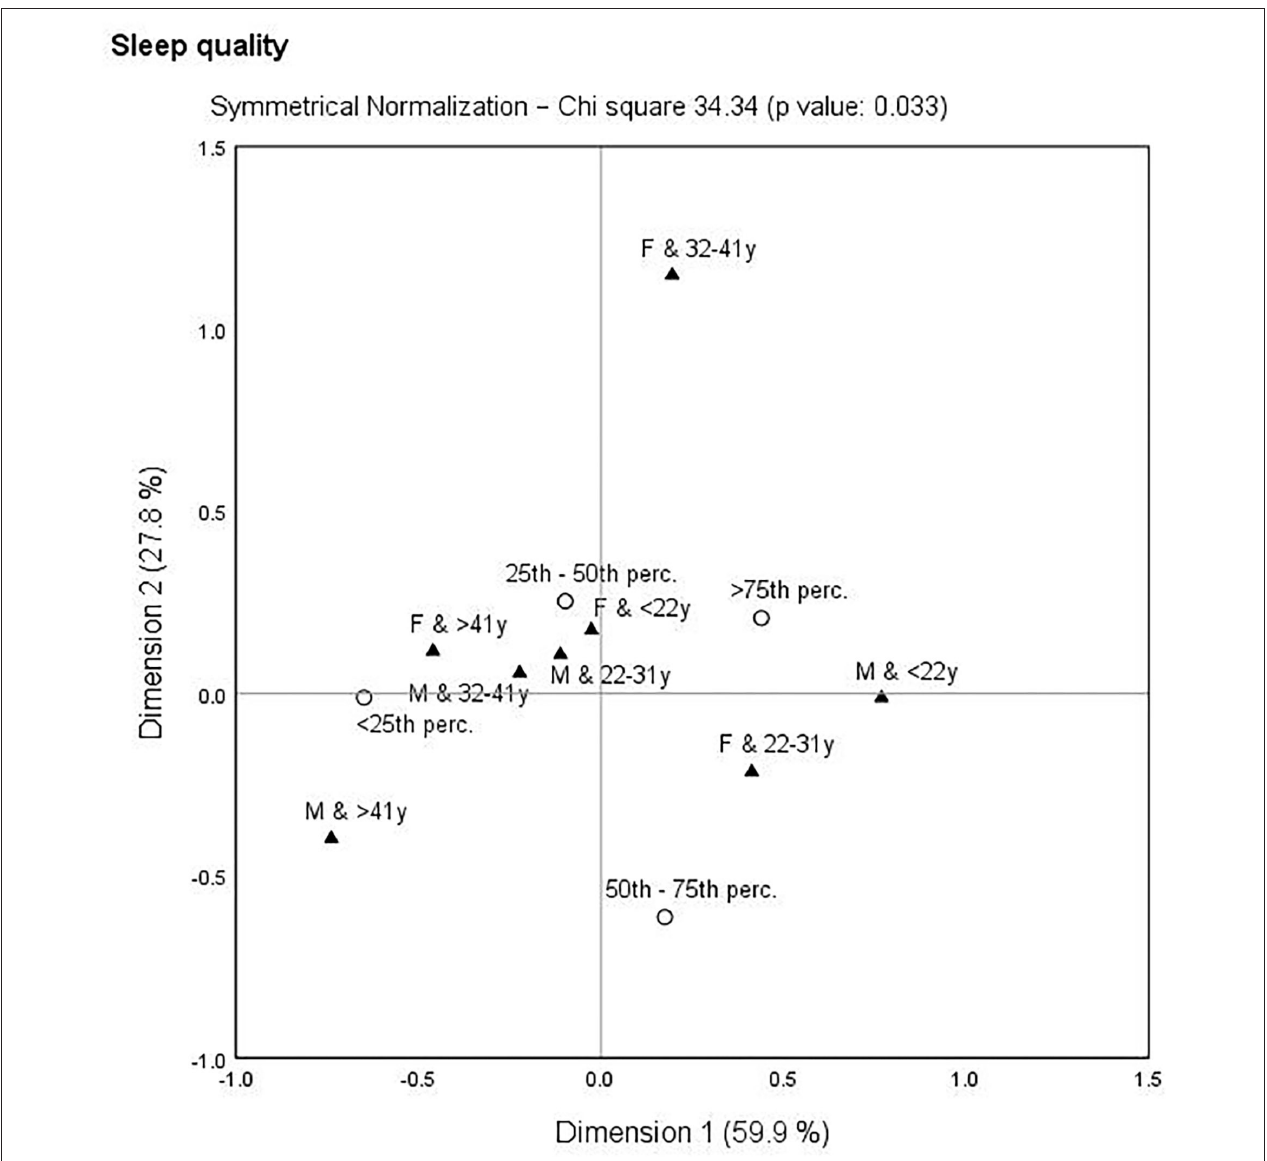
FIGURE 3 | Correspondence map—sleep quality (SLP) and gender-age characteristics.